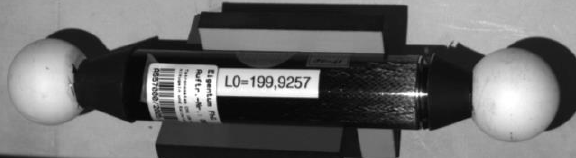
Figure 9. Specimen for calibration: calibrated ball bar